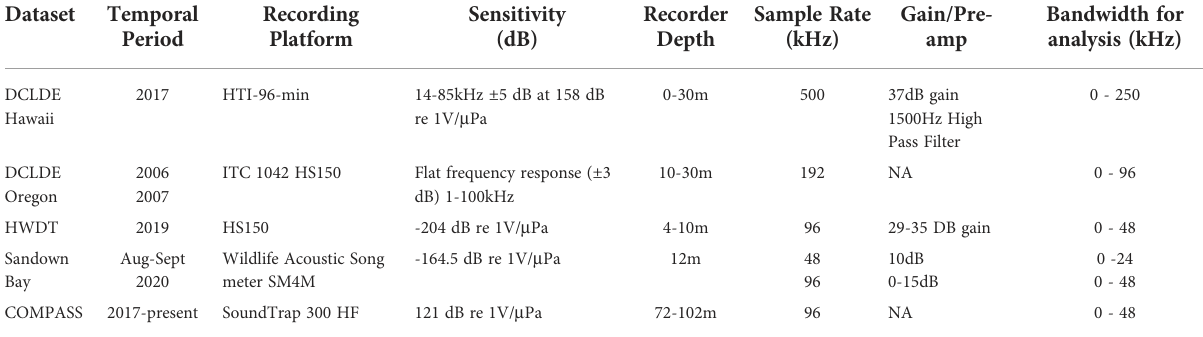
TABLE 1 Description of the recording apparatus, and acoustic settings used to obtain the PAM data for DCLDE, HWDT, Solent and COMPASS data collections used in this study.